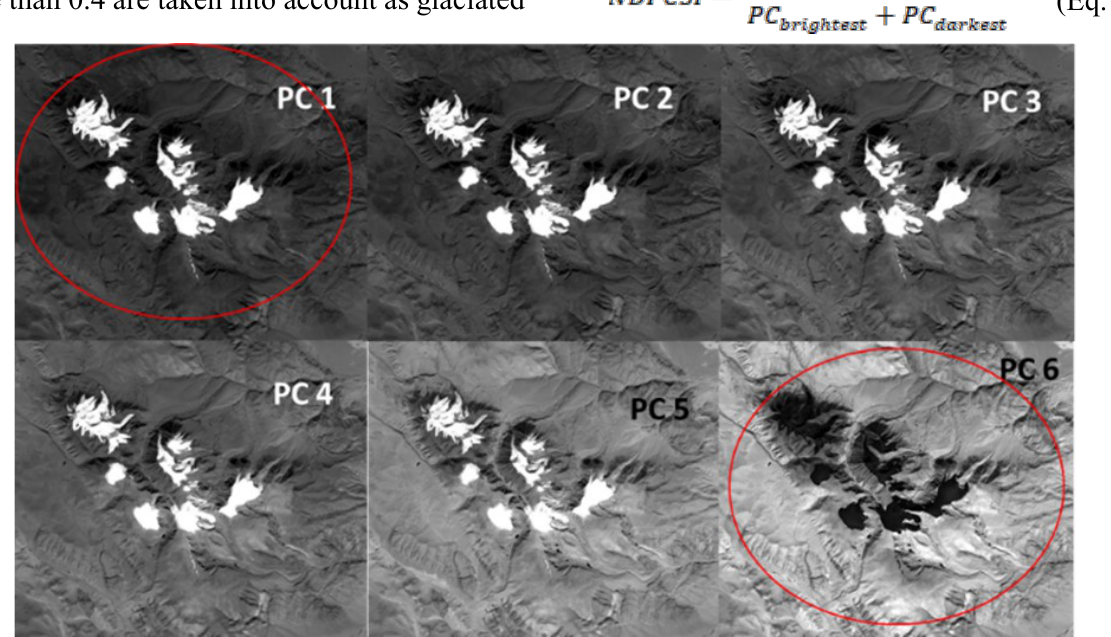
Fig. 3. Maps from channel PC 1 to channel PC 6 of Landsat data showing the areas of modern glacier in Mt. Tsambagarav based on NDPCSI: Source data on 09.17.2017